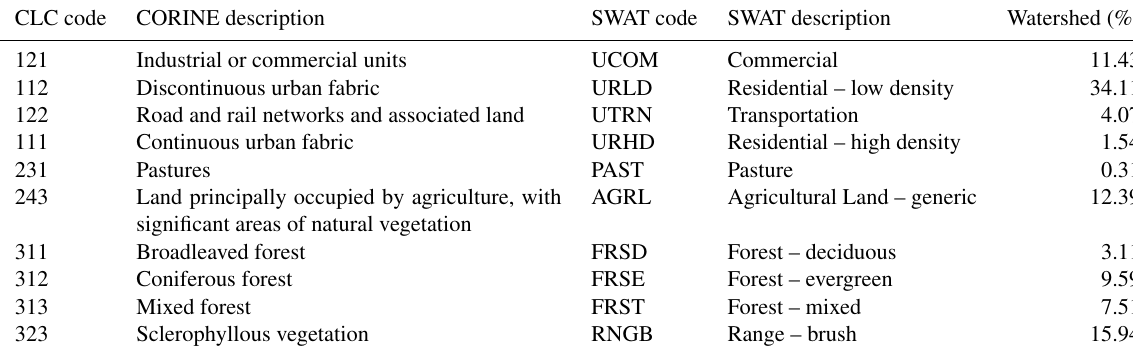
Table 2. Land use classification of the Kifisos basin and the corresponding SWAT land use category. CLC